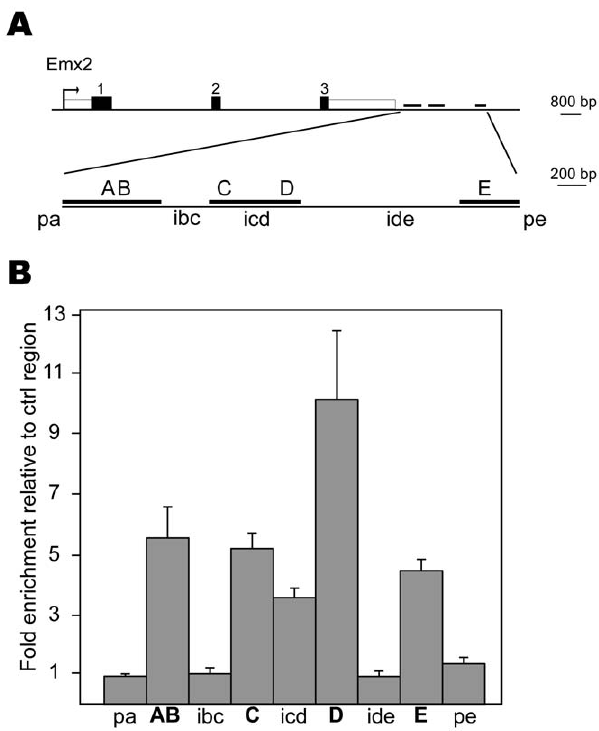
Figure 6. Pax2 directly binds the Emx2 gene through a conserved 3 9 regulatory region. (A) Schematic representation of the Emx2 locus. Arrow indicates start site, black boxes exons 1,2,3 and white box indicate 3 9 UTR. Thick black lines represent conserved regions between mouse and human sequences. Five sites (A,B,C,D and E) were identified by bioinformatics analysis. Primer pairs used for chromatin immunoprecipitation experiment are labeled A to E and pa (pre-site A), ibc, icd, ide (inter-BC, inter-CD and inter-DE, respectively) and pe (post- site E). (B) Chromatin immunoprecipitation with anti-Pax2 antibody in mIMCD3 cells for the sites indicated in (A). Results are expressed as fold enrichment compared to an unrelated control region (near FoxO6